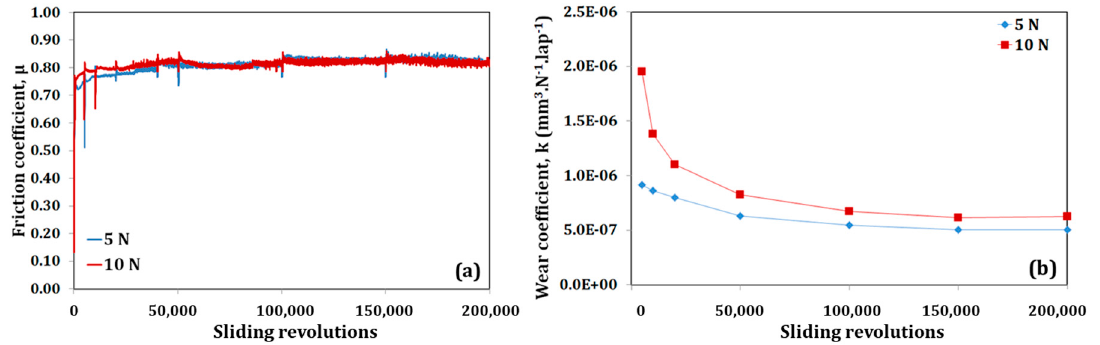
Figure 13. Representative ball-on-disk testing results of the FCWA hardfacing layers (counterbody: Al 2 O 3 ball): evolution of ( a ) friction coefficient and ( b ) wear coefficient vs. sliding revolutions.